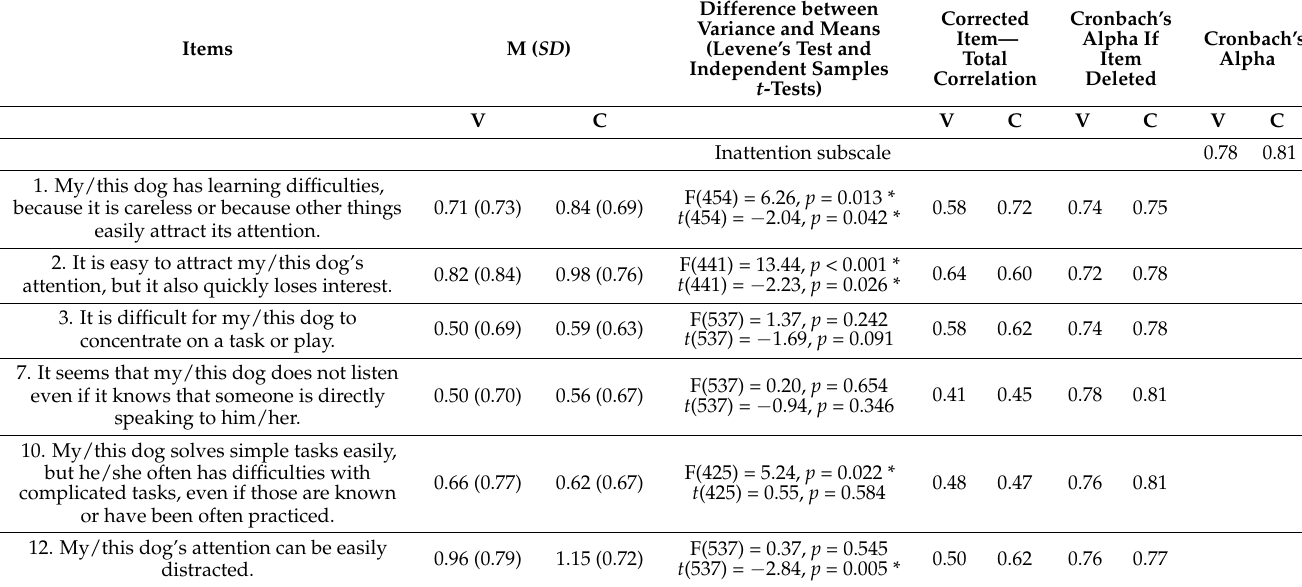
Table 3. Descriptive statistics, cross-study differences, and indices of reliability across individual items of the V Dog ARS for the prior Vas et al. (V) ( N = 220) [14] and the current C Dog ARS (C) sample ( N = 319) for Aim 1/Question 1 and Aim 2/Question